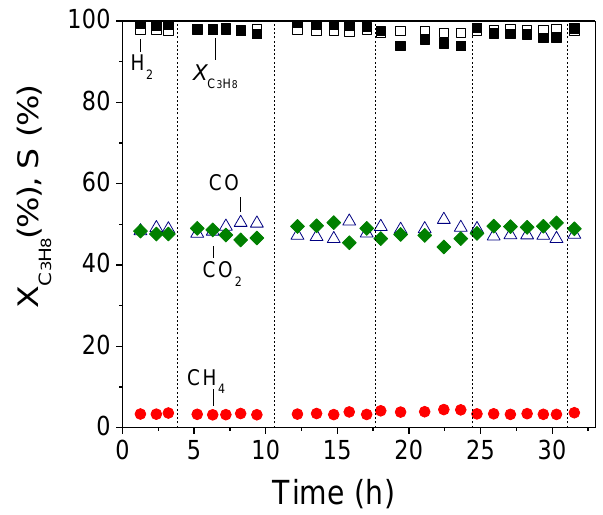
Figure 6. Long-term stability test of the 5%Ni/ZrO 2 catalyst at 650 °C: Alterations of the conversion of C 3 H 8 and selectivities toward reaction products with time-on-stream. Experimental conditions: Same as in Figure 3. Dashed vertical black lines indicate shutting down of the system overnight.